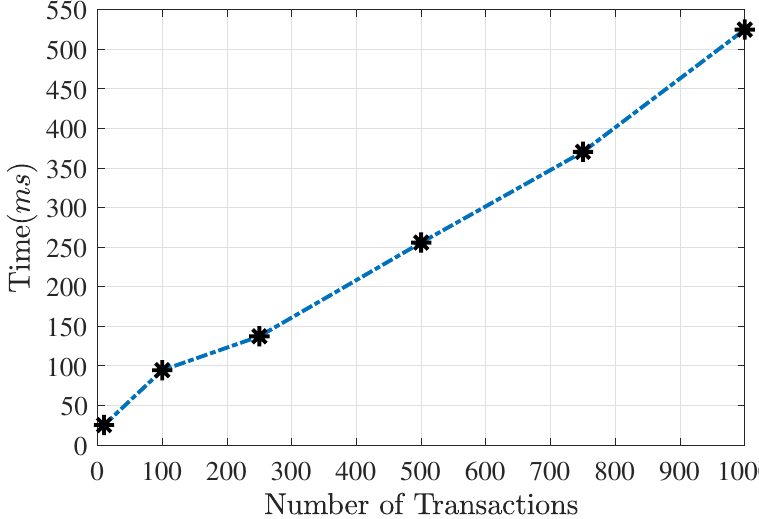
Figure 6. Time for mining and broadcasting one block versus the number of transactions.